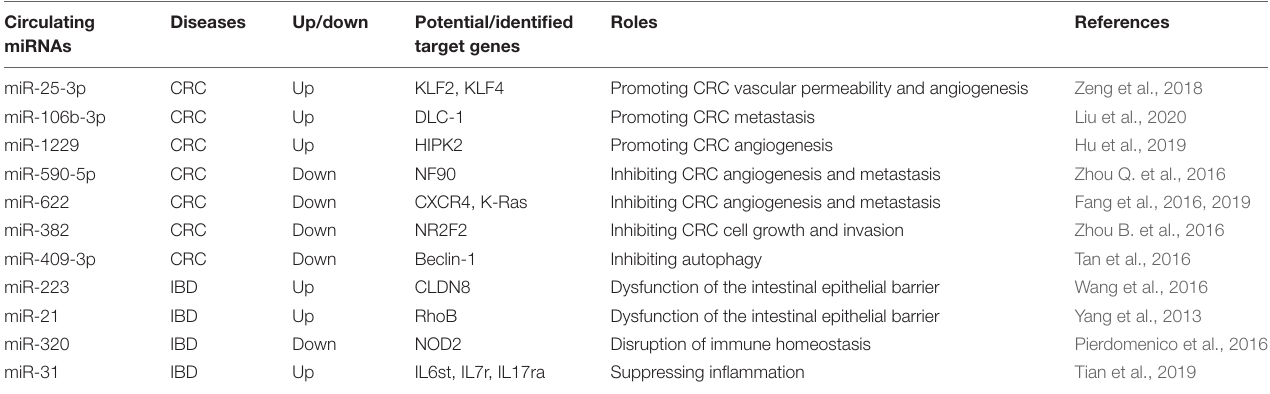
TABLE 1 | Circulating miRNAs and their possible/identified targets in different gastrointestinal disorders.